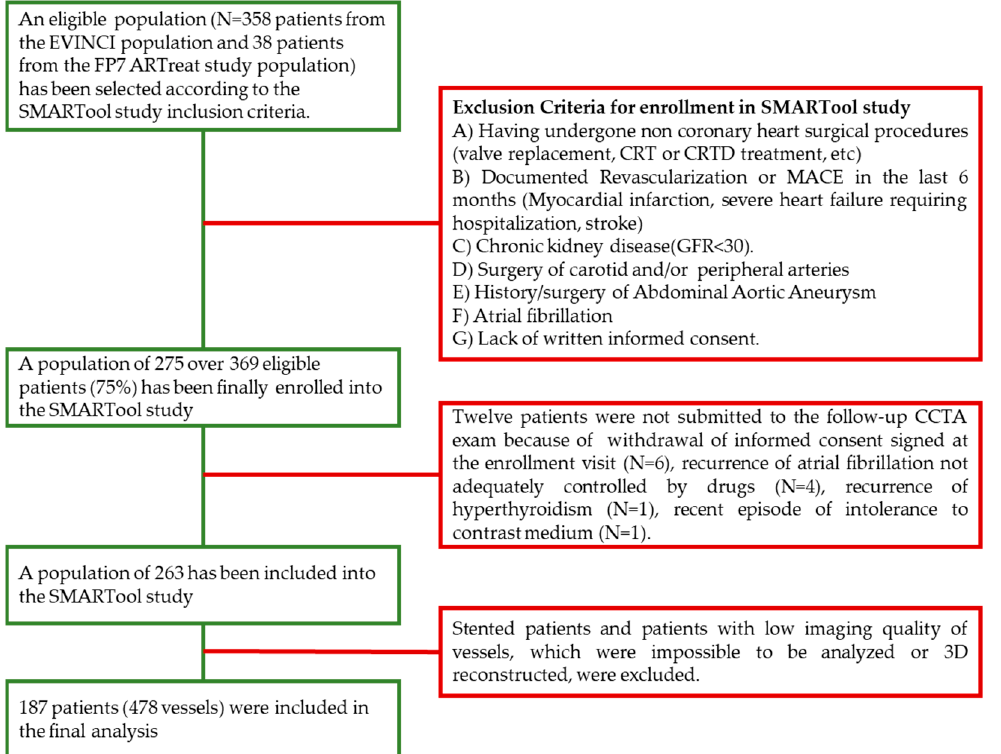
Figure 1. Inclusion and exclusion criteria of the current study.